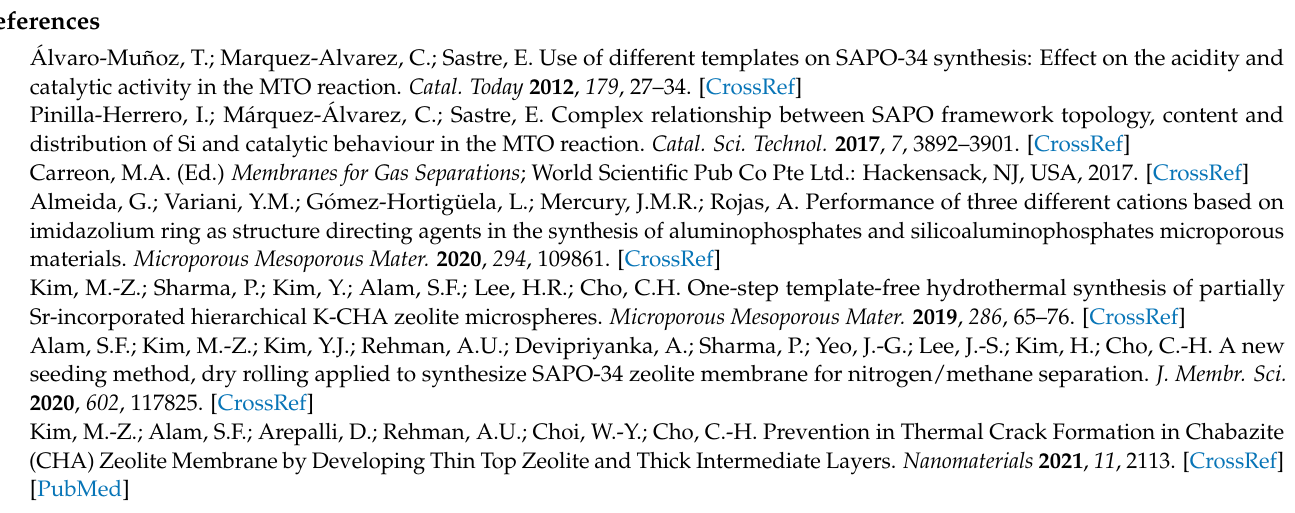
Figure S2: DLS data for the synthesized particles with variation in time for phosphoric acid addition, Figure S3: (a) SEM images for the samples with variation of Si concentration z = (i) 0.4, (ii) 0.5, and (iii) 0.6, and (b) XRD for the samples with variation of Si concentration z = (i) 0.4, (ii) 0.5, and (iii) 0.6, Figure S4: A comparison of composition of SAPO-34 particles from literature for the Si/Al and P/Al ratio, Figure S5: The morphological distribution for various compositions of SAPO-34 particles in literature. Table S1: EDX compositional analysis of the synthesized SAPO-34